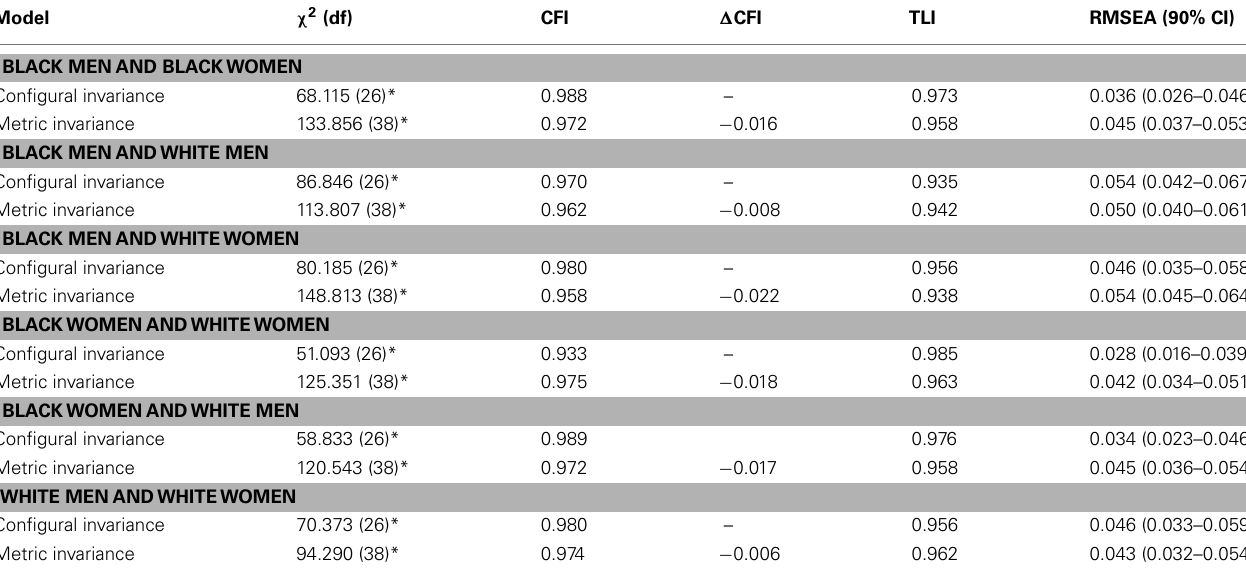
Table 5 | Measurement invariance tests between race–sex subgroup pairs, two-factor model. Model